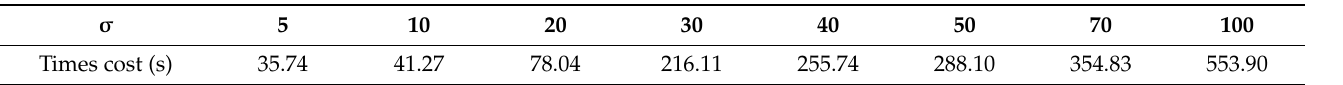
Table 3. The computation time of the proposed method with different noise standard deviations ( σ ).